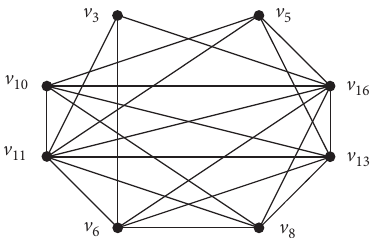
Figure 5: Graph G I ( Λ ), where Λ = < 3, 5, > and I is an irreducible ideal with x =16.